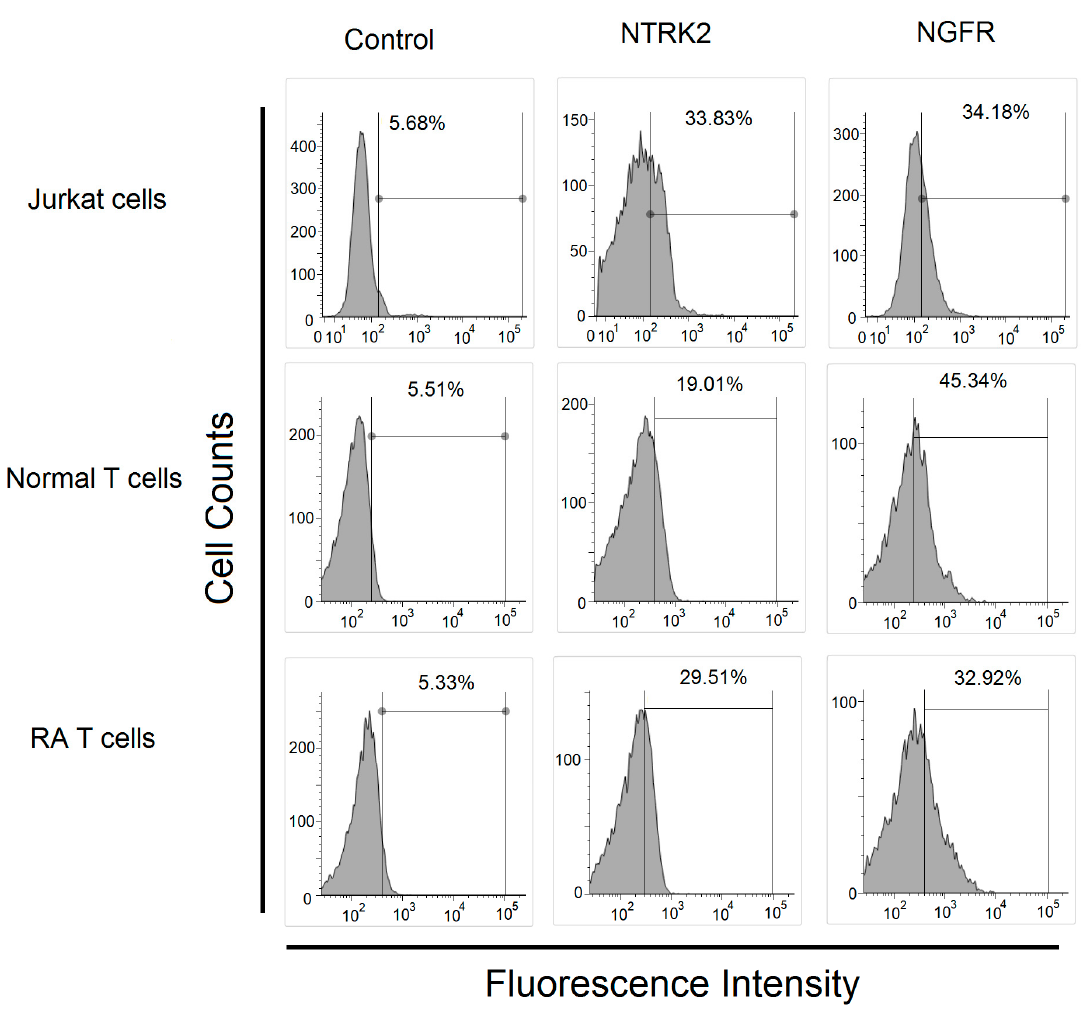
Figure 2. Expression of BDNF receptor in Jurkat cells and T cells from healthy controls and patients with rheumatoid arthritis. The expression of BDNF receptors, including neurotrophic receptor tyrosine kinase 2 (NTRK2) and nerve growth factor receptor (NGFR) in Jurkat cells, T cells from healthy controls and patients with rheumatoid arthritis analyzed using flow cytometry.